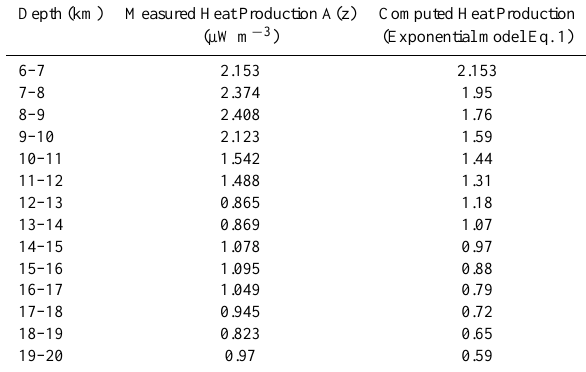
Fig. 6. Log-log plot of power spectrum of heat production data vs wave number for the KTB borehole (Germany). Computed linear fit gives a scaling exponent of 0.9 conforming to fractal behavior in the data set. Considerable scattering can be seen towards the lower wave number indicating high variability in the measured heat production. Value of scaling exponent, as obtained in this case, is much lower than that obtained for other cases.